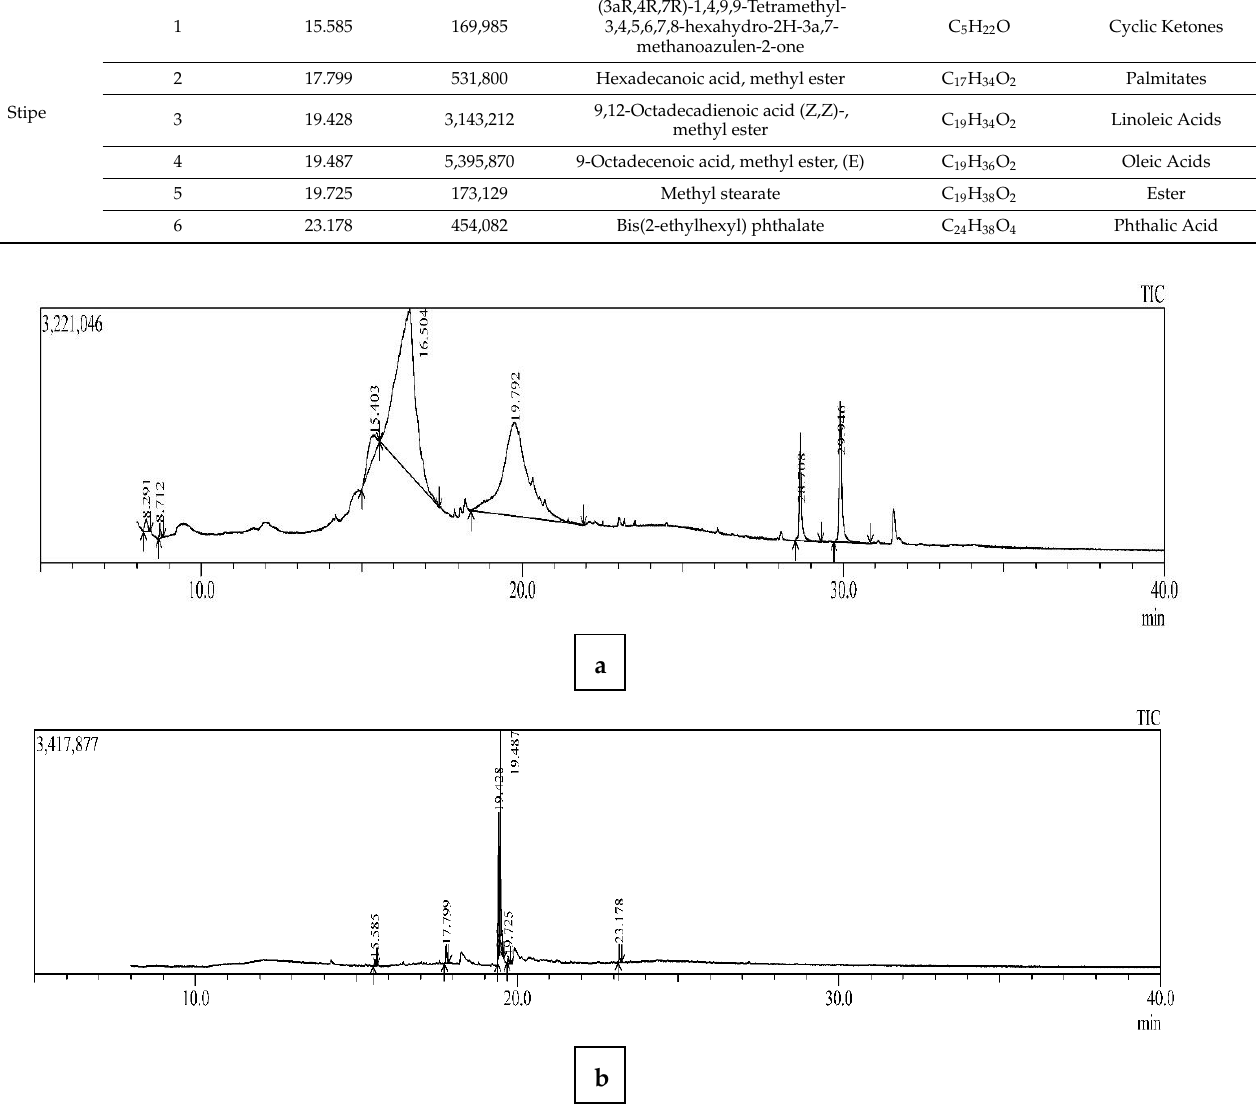
Figure 5. GC-MS chromatogram showing peaks of bioactive compounds obtained from ethanolic extract of G. lucidum parts: ( a ) pileus and ( b ) stipe.